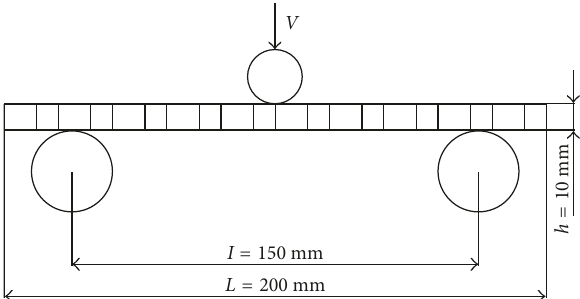
Figure 2: Schematic of quasistatic three-point bending